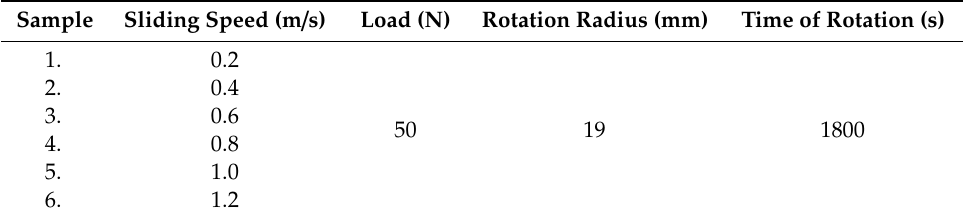
Table 3. Measurement parameters for tribology.